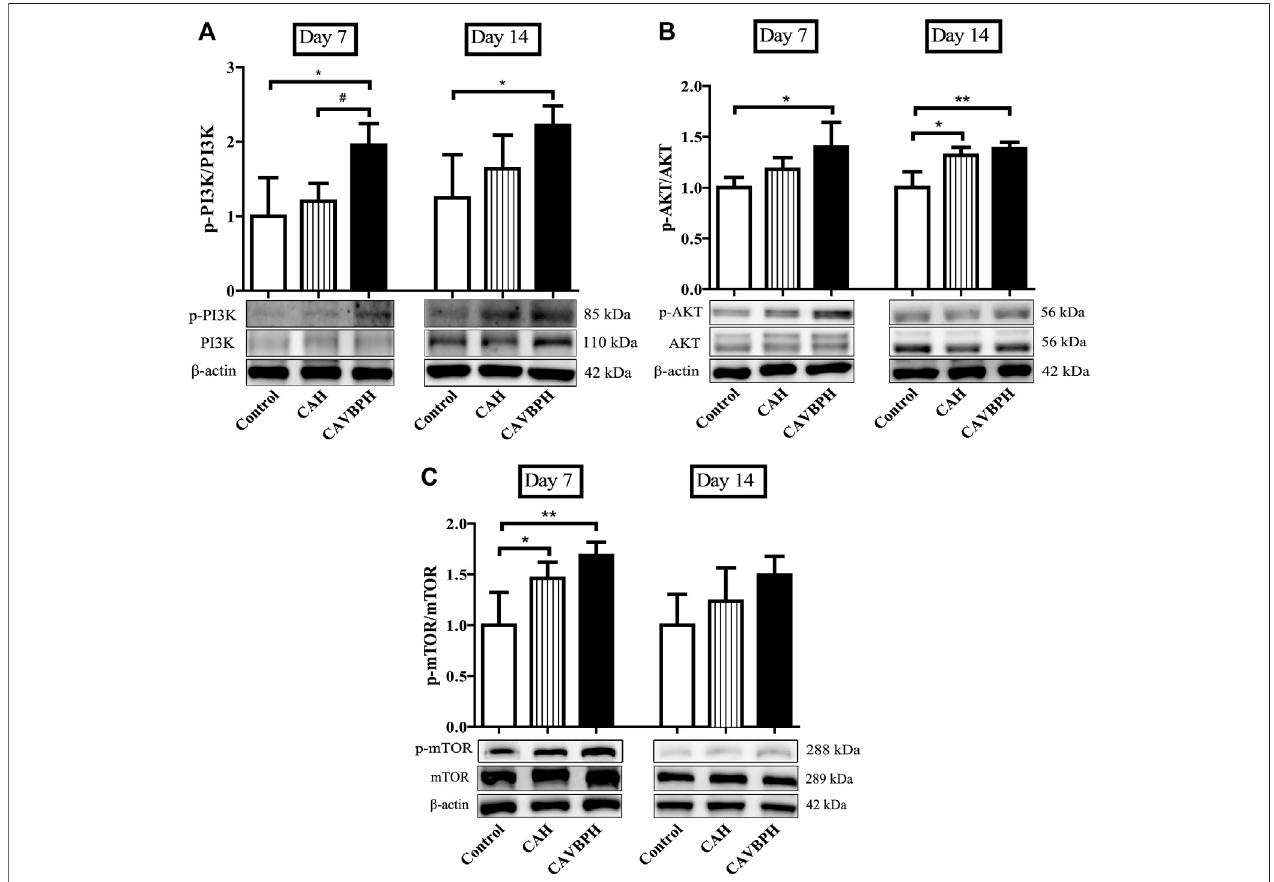
FIGURE 6 | Western blotting analysis of the PI3K/AKT/mTOR pathway. (A) Protein bands and quantitative analyses of p-PI3K and PI3K. (B) Protein bands and quantitative analyses of p-AKT and AKT. (C) Protein bands and quantitative analyses of p-mTOR and mTOR. * p < 0.05, ** p < 0.01, *** p < 0.001 vs . control; # p < 0.05, ## p < 0.01, ### p < 0.001 vs . CAH as statistically signi fi